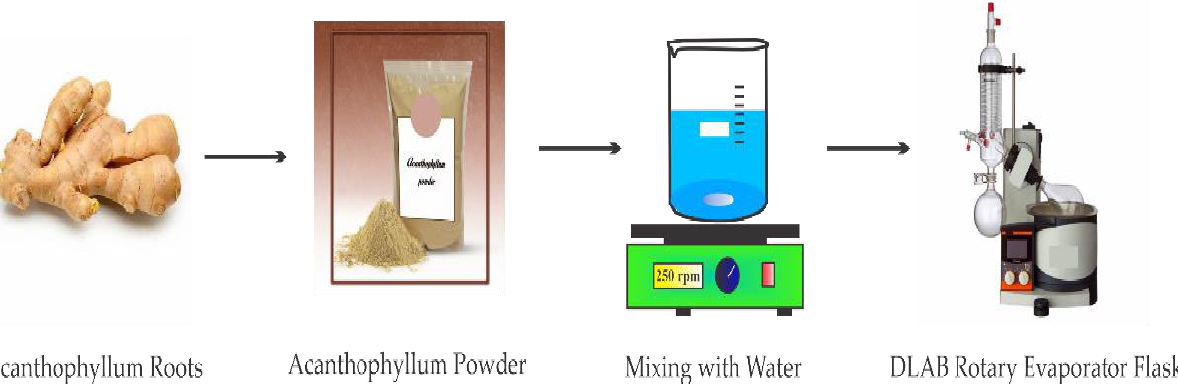
Figure 2. Experimental procedures used in preparing the Azarboo